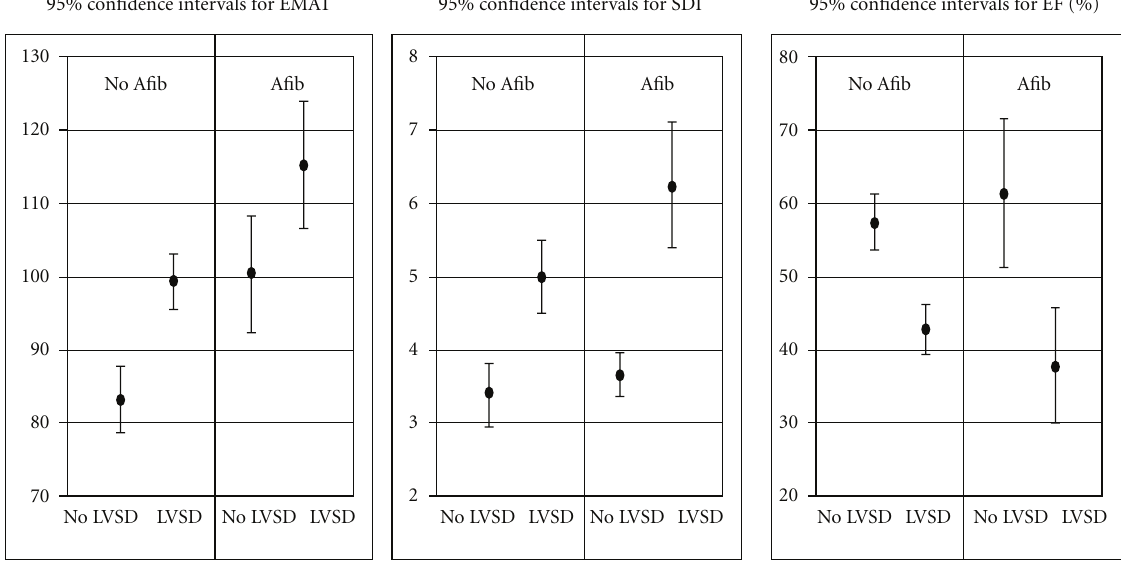
Figure 1: The means and 95% confidence intervals for electromechanical activation time (EMAT), the systolic dysfunction index (SDI) and ejection fraction (EF) for populations with and without left ventricular systolic dysfunction (LVSD). Afib: atrial fibrillation; EMAT: electromechanical activation time, msec; SDI: systolic dysfunction index; EF: ejection fraction, %; LVSD: left ventricular systolic dysfunction, defined as LV max(dP/dt) < 1600